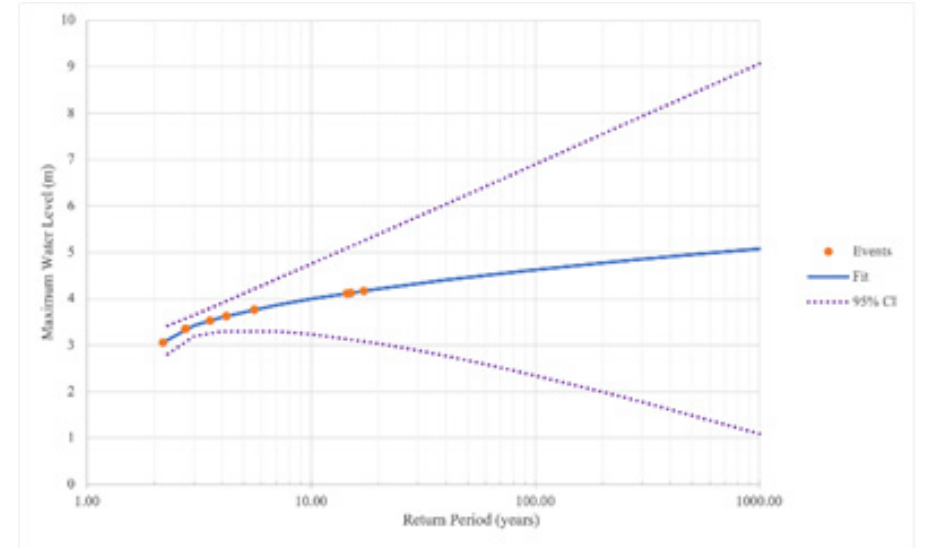
Figure 10. Weibull distribution with k = 2 applied to the nine storms.